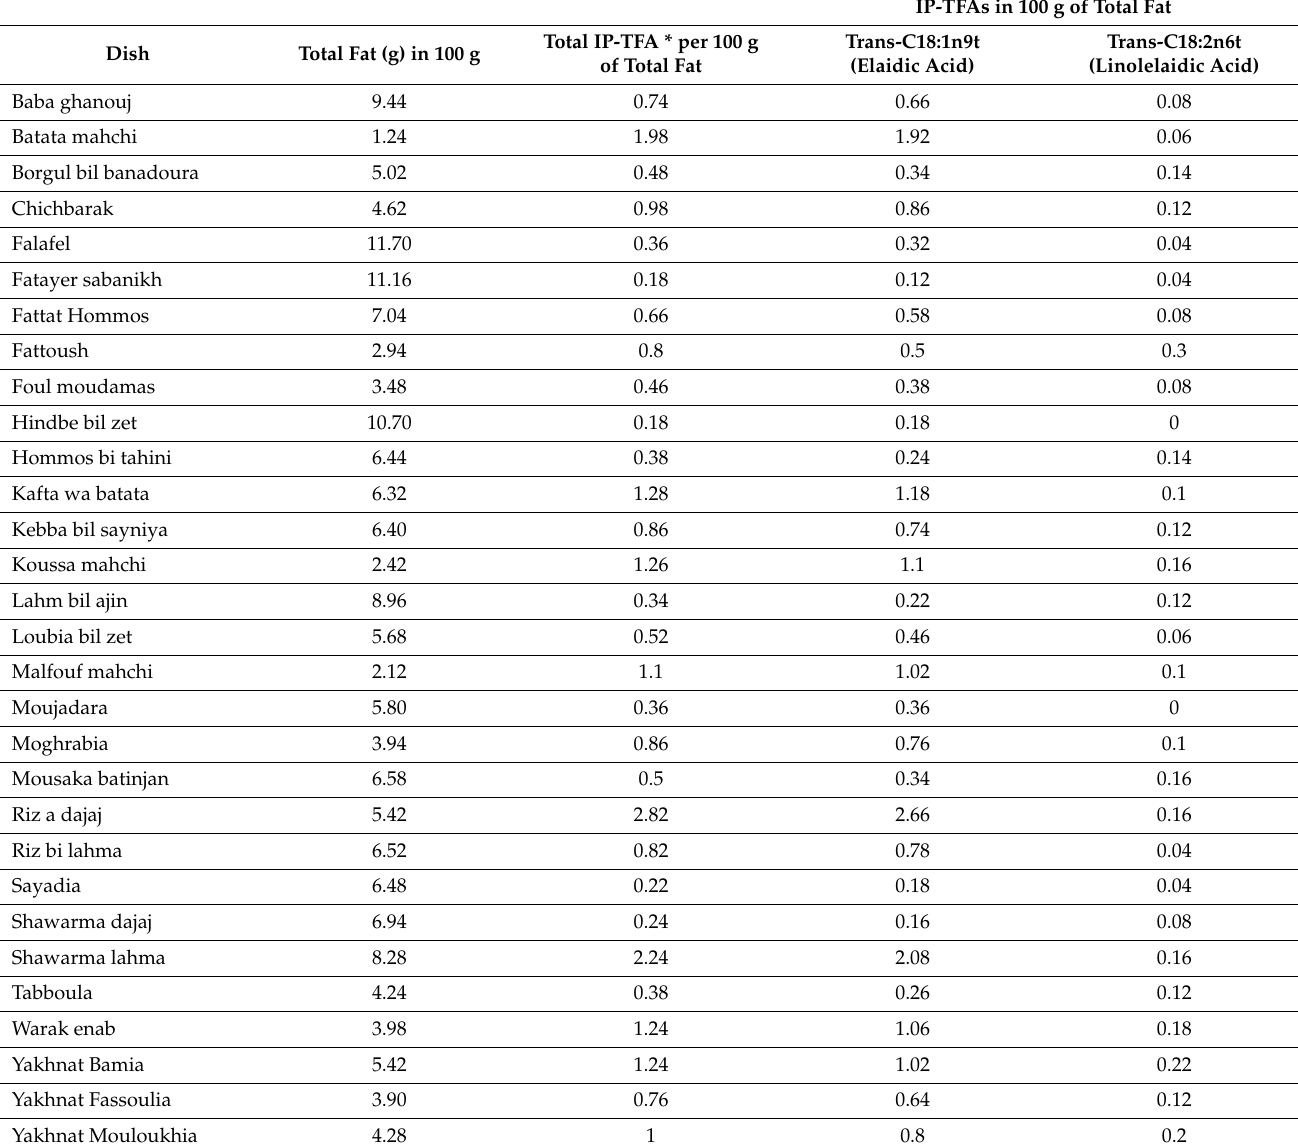
Table 1. Total fat in 100 g of edible portions, total IP-TFAs and IP-TFAs (EA and LEA) in 100 g of fat of frequently consumed traditional dishes among all Lebanese